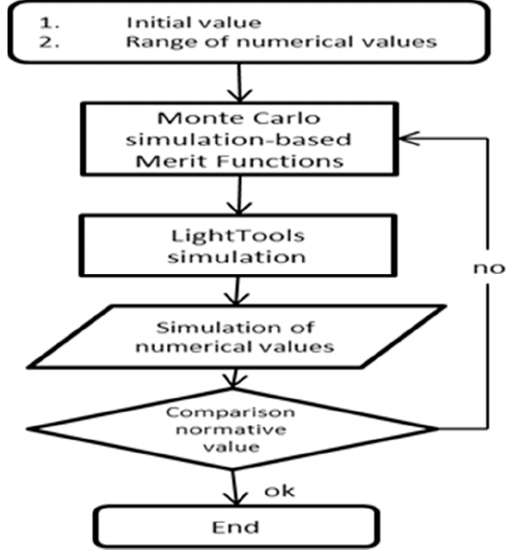
Figure 10. Optimization process via LightTools based on Monte Carlo merit function.